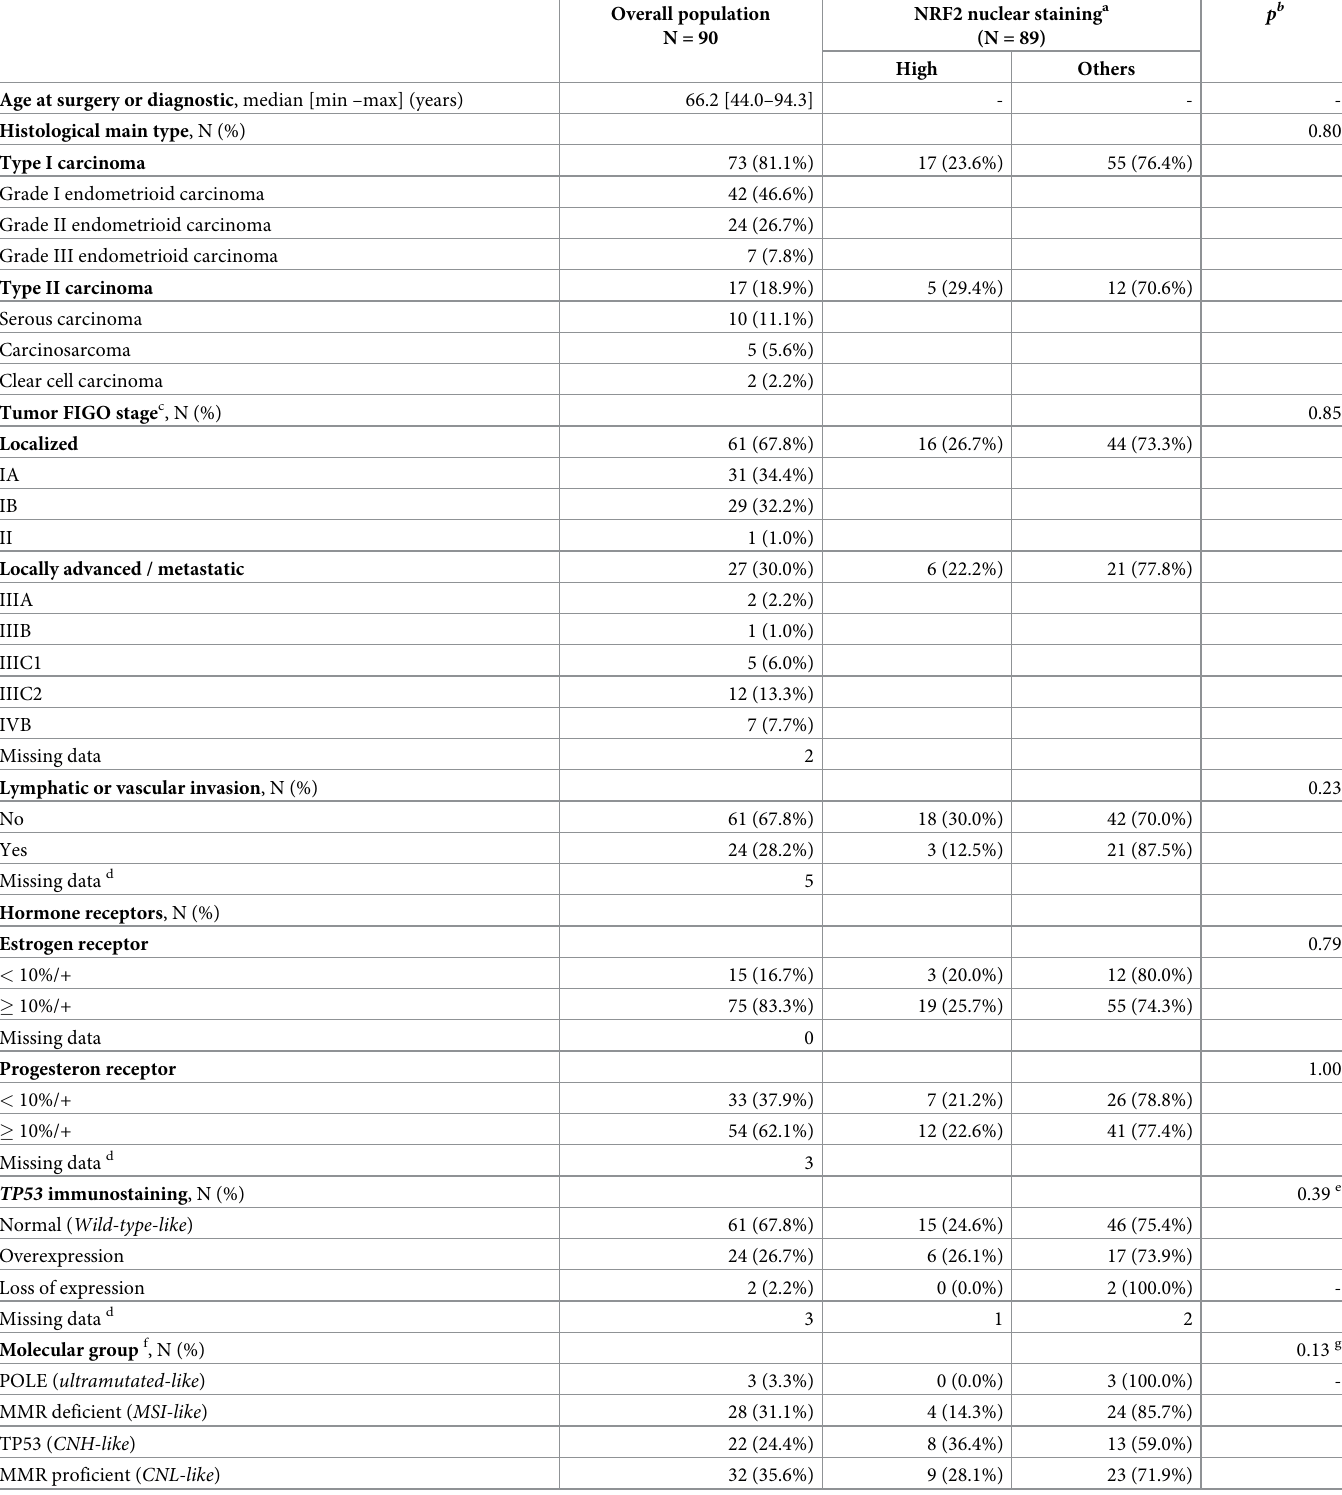
Table 1. Clinical and pathological characteristics in the overall population and according to NRF2 nuclear